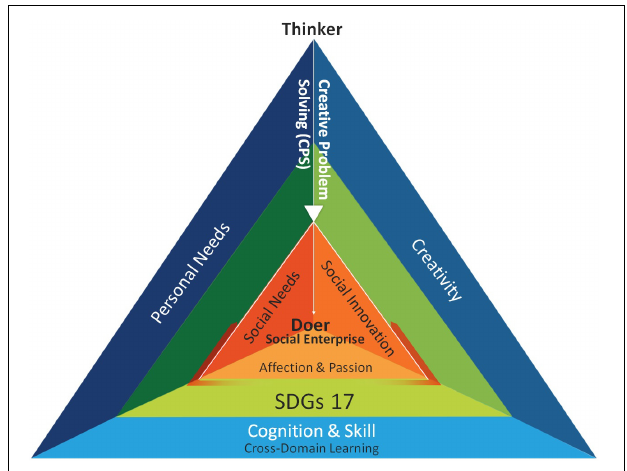
FIGURE 3 | The sustainability-oriented CIE education framework (aerial